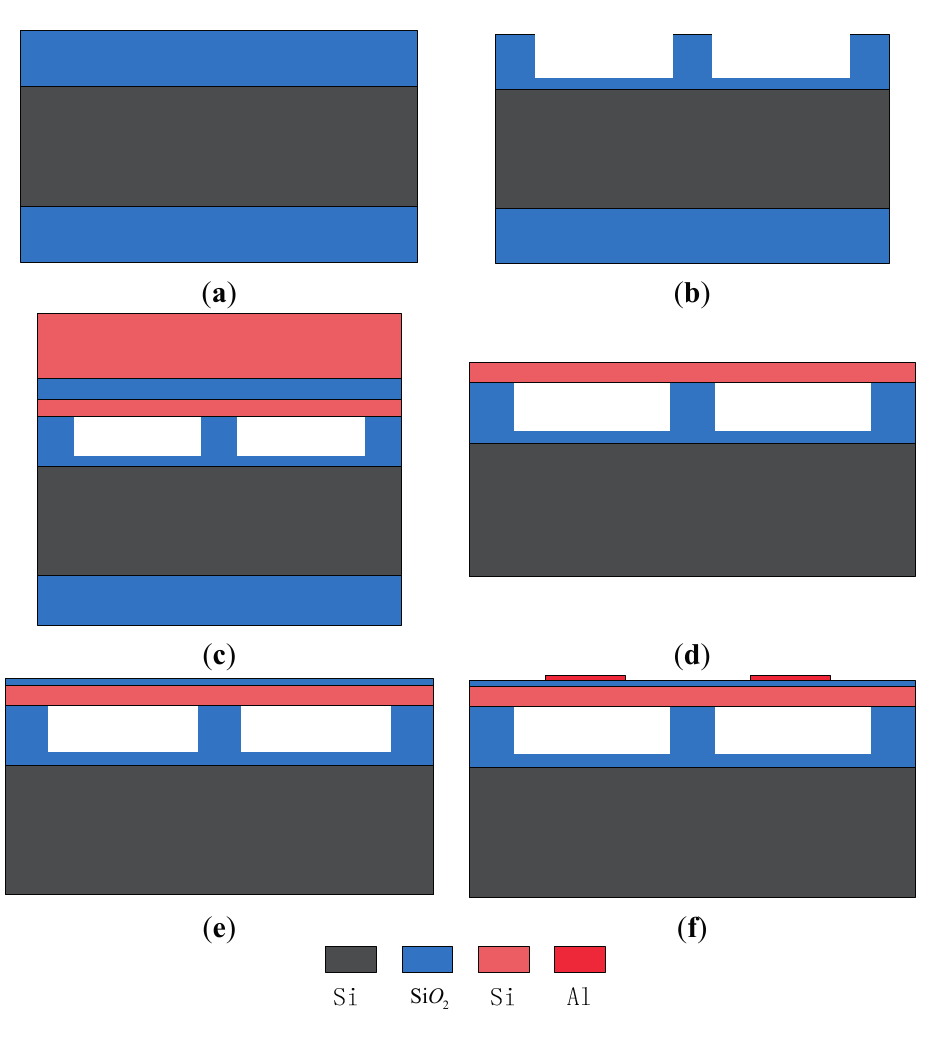
Figure 2. The main fabrication